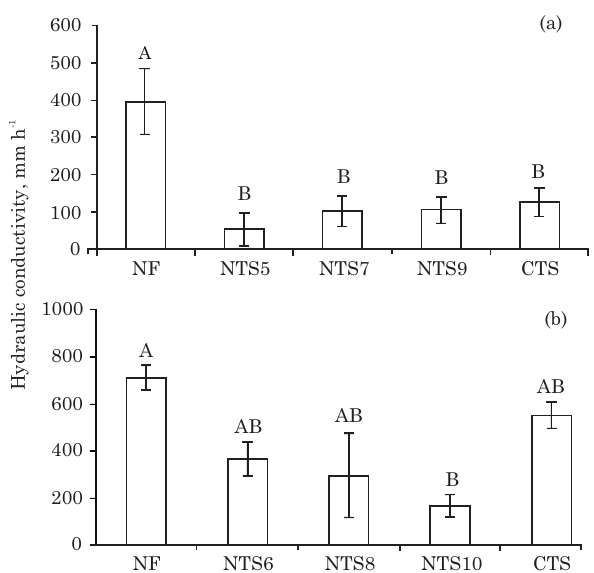
Figure 3. Saturated hydraulic conductivity of a Red Oxisol under soybean (a) (2008/09 growing season) - NF: native forest, NTS5: five-year no- tillage system, NTS7: seven-year no-tillage system, NTS9: nine-year no-tillage system, and CTS: conventional tillage system; and of corn (b) (2009/10 growing season) – NF: native forest, NTS6: six-year no-tillage system, NTS8: eight- year no-tillage system, NTS10: ten-year no-tillage system, and CTS: conventional tillage system. The bars indicate the mean standard